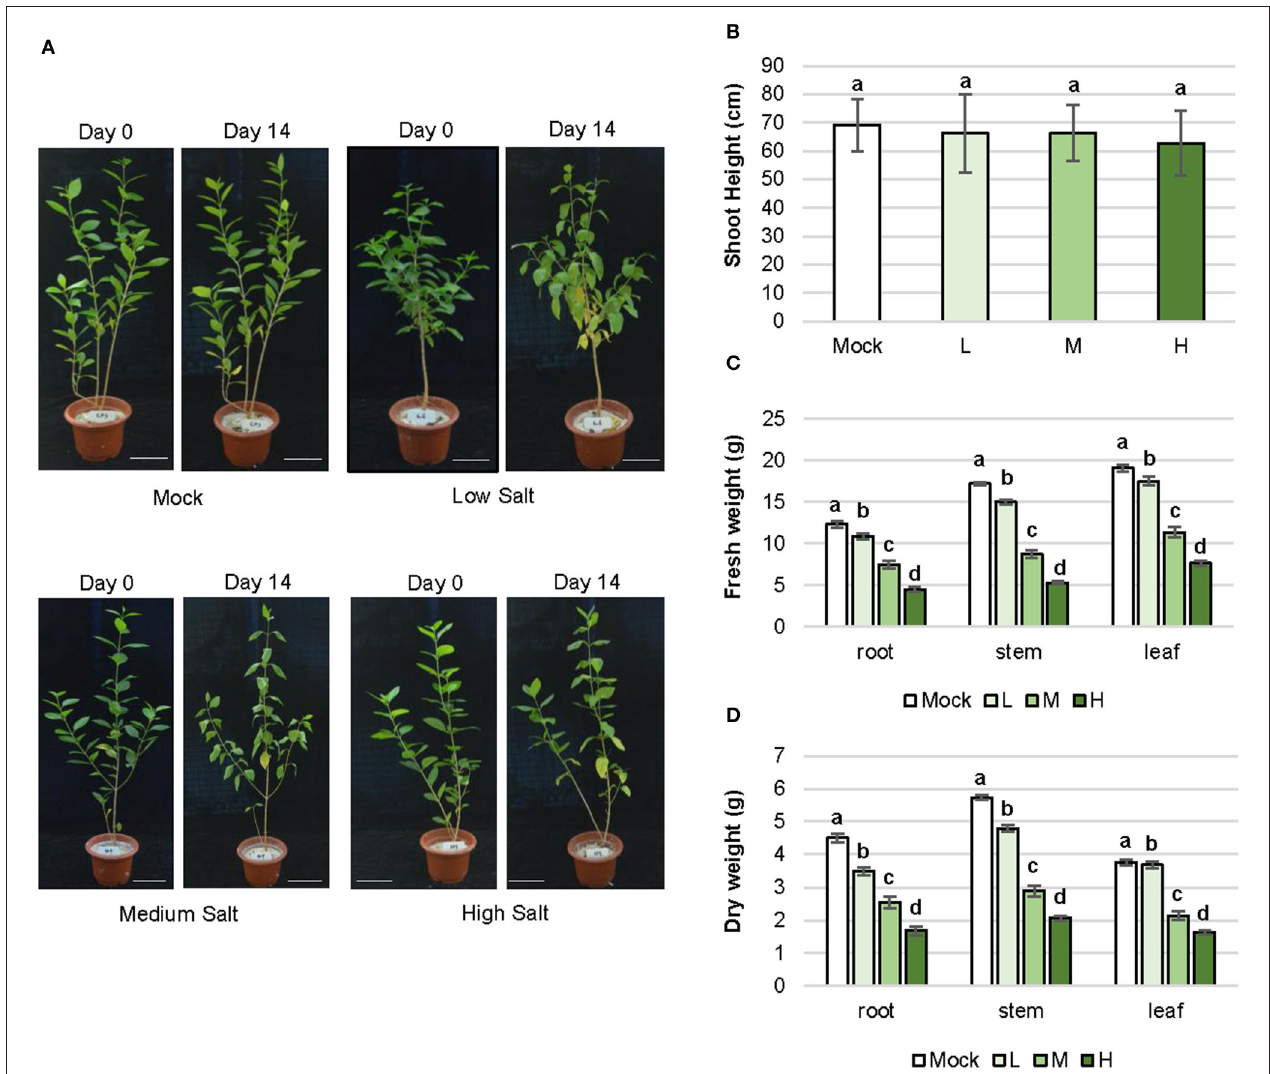
FIGURE 1 | Morphogenesis and biomass alteration of C. inerme in response to salinity stress. (A) Plant architecture of C. inerme on day 0 and day 14 after corresponding salt treatment. Shoot height (B) , fresh weight (C) and dry weight (D) of root, stem and leaf respectively on day 14 under NaCl stress. Different letters indicate significant differences among plant groups ( p < 0.05, Mann Whitneytest). Mock, no salt control; L, low salt stress; M, medium salt stress; H, high salt